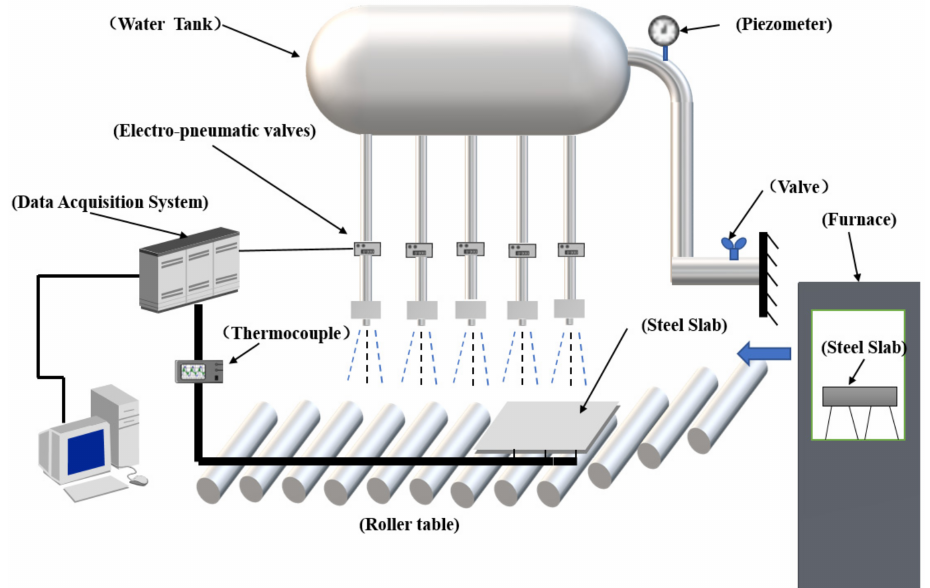
Figure 1. Schematic diagram of the laminar cooling experimental